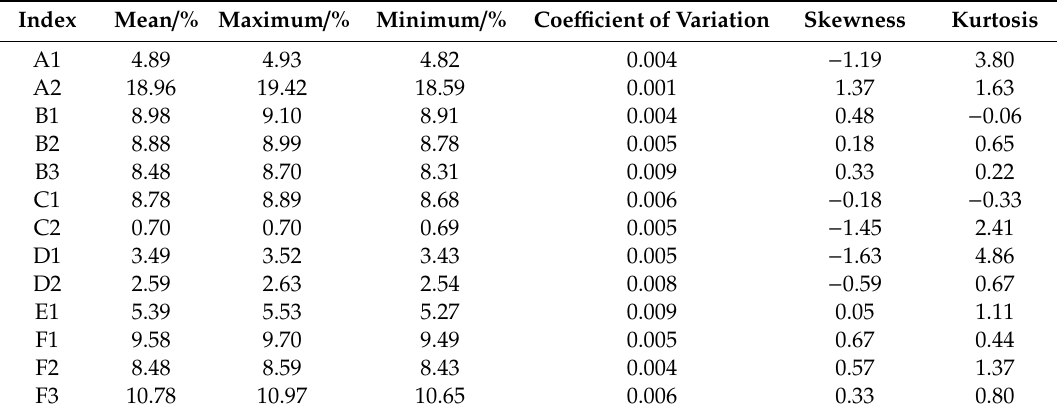
Table 4. Statistical characters of obstacle amounts against the performance of